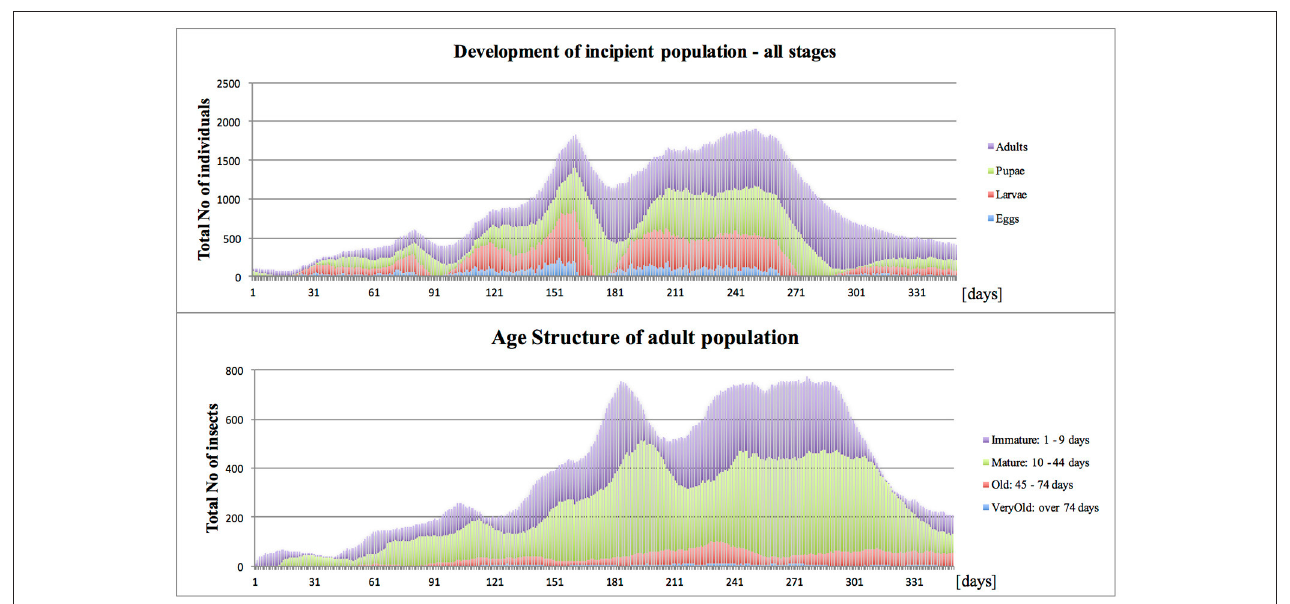
FIGURE 8 | Propagule development in optimal conditions (Start, end of March; site, Farm Site; Opt climate, average = 22.9 ◦ C, min = 20 ◦ C, max = 25 ◦ C).